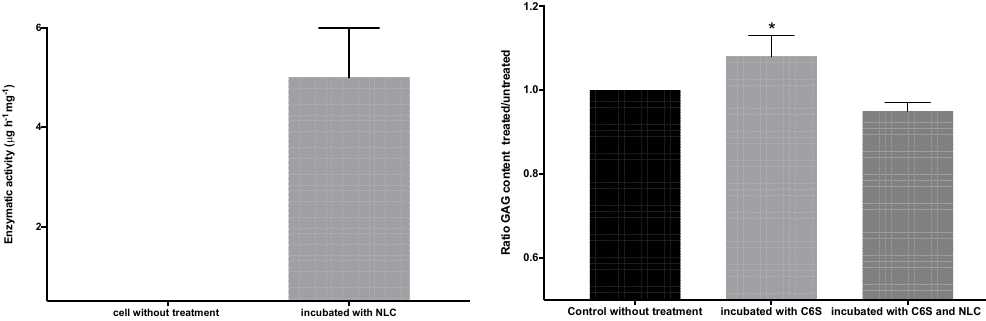
Figure 13. GALNS activity (left graph) and reduction of the glycosaminoglycan (GAG) lysosomal deposits of pathological fibroblasts before and after incubation in a suspension of elosulfase alfa-NLC.